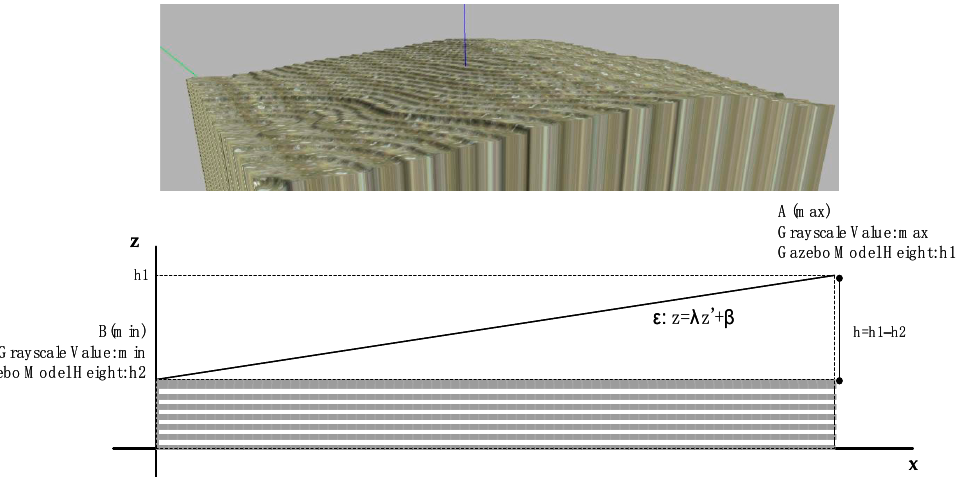
Figure 6. Field layout environment in AgROS comprises of: ( a ) Standard Open Street Maps; ( b ) digital elevation model for the region; ( c ) exact geographical region; and ( d ) 3D landscape to be used in Gazebo.